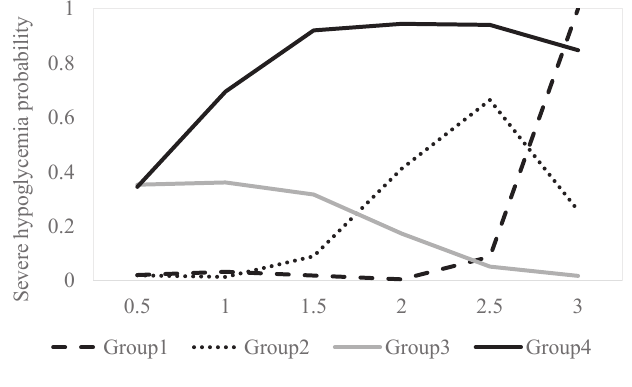
Figure 1. Trajectory of severe hypoglycemic episodes oc- curring within 3 years after enrollment. Group 1: very late manifestation (18.06% probability); Group 2: late manifestation (33.19% probability); Group 3: early manifestation with later decrease (43.25% probability); Group 4: early and sustained manifestation (5.50%